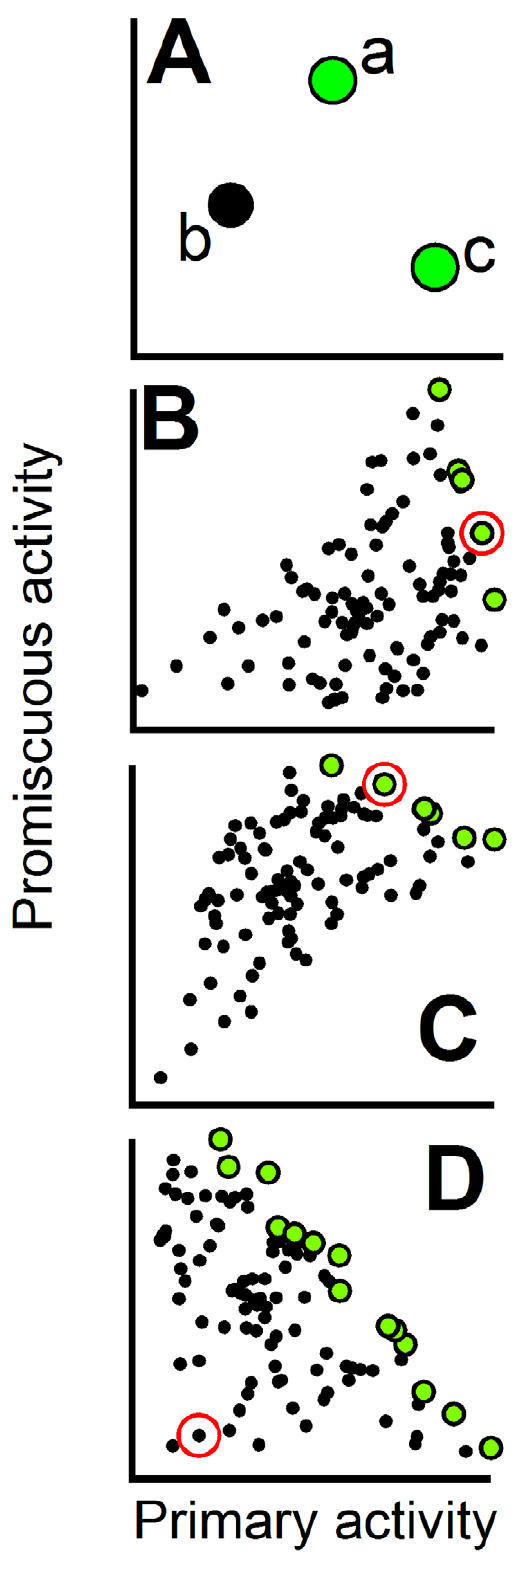
Figure 1. Use of the Pareto set to define the patterns of primary/promiscuous activity modulation. In all plots, each data point represents the primary and promiscuous activity data for a given protein variant. Different variants may be thought as corresponding to different combinations of mutations from a given set. (A) Illustration